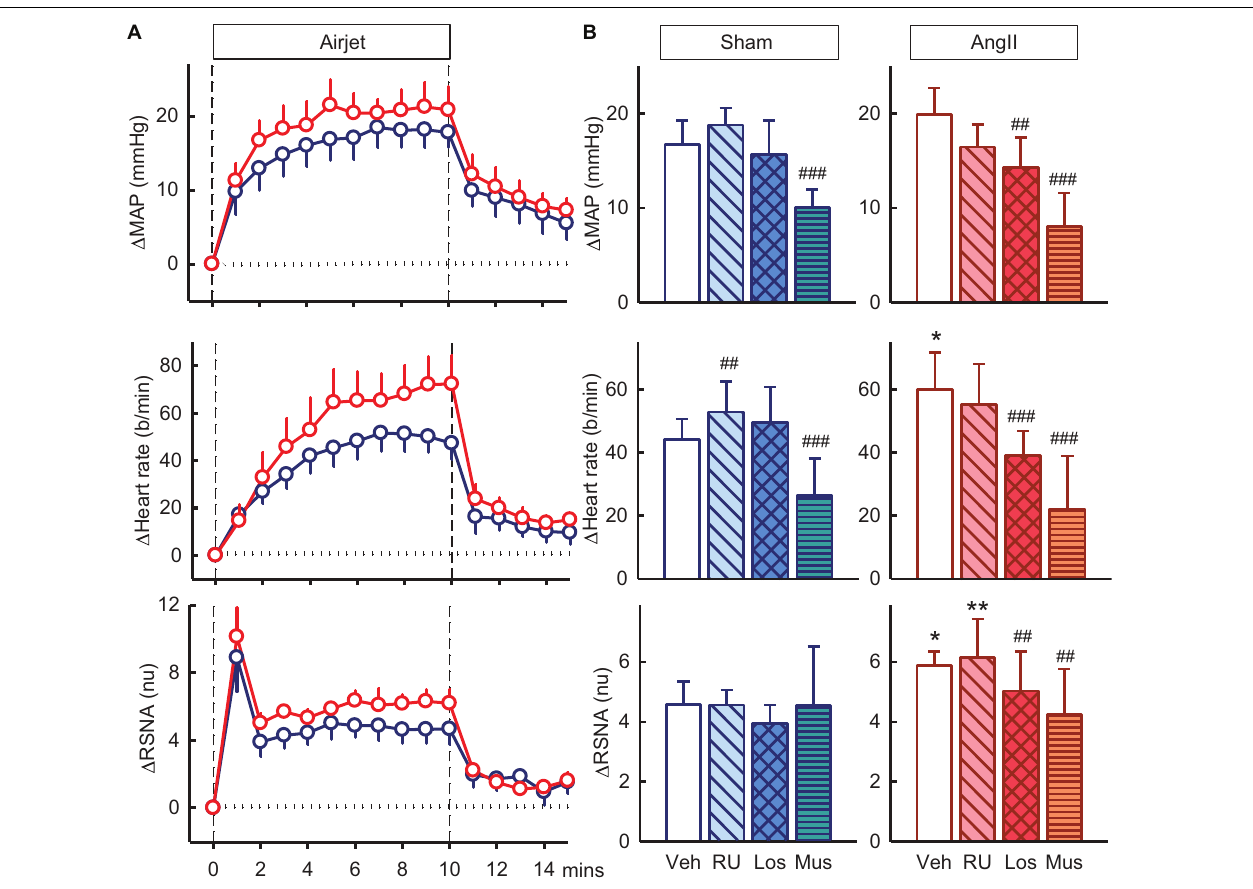
FIGURE 6 | Effects of antagonists and agonist on mean arterial pressure (MAP), heart rate and total renal sympathetic nerve activity (RSNA, normalized units) responses to air jet stress. (A) Line graphs show time course of changes from control in vehicle-treated sham (blue circles) and Ang II (red circles) rabbits to air jet (vertical dashed lines). (B) Bar graphs are average change from control in sham (left) and Ang II (right) rabbits treated with vehicle (veh, white, n = 8–10), RU28318 (RU, n = 8–10, diagonal hatch), losartan (Los, n = 7, cross hatch), and muscimol (Mus, n = 5–6, horizontal hatch). Data are mean difference ± SED, * P < 0.05 and ** P < 0.01 for Ang II vs sham; # P < 0.05, ## P < 0.01, and ### P < 0.001 for antagonist or agonist vs